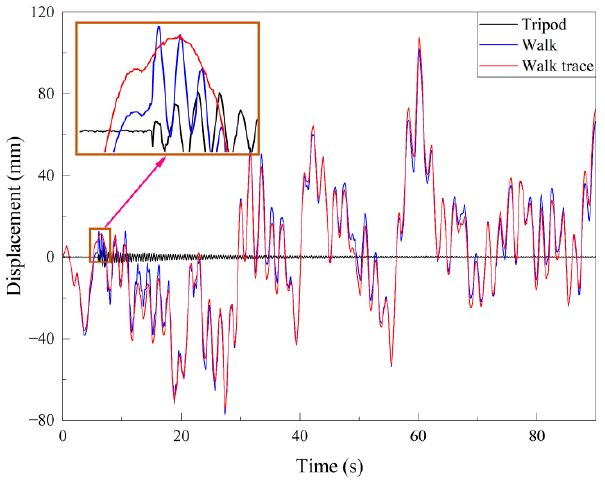
Figure 14. Displacement time history comparison under the shooting state of slightly walking hand-held smartphone.